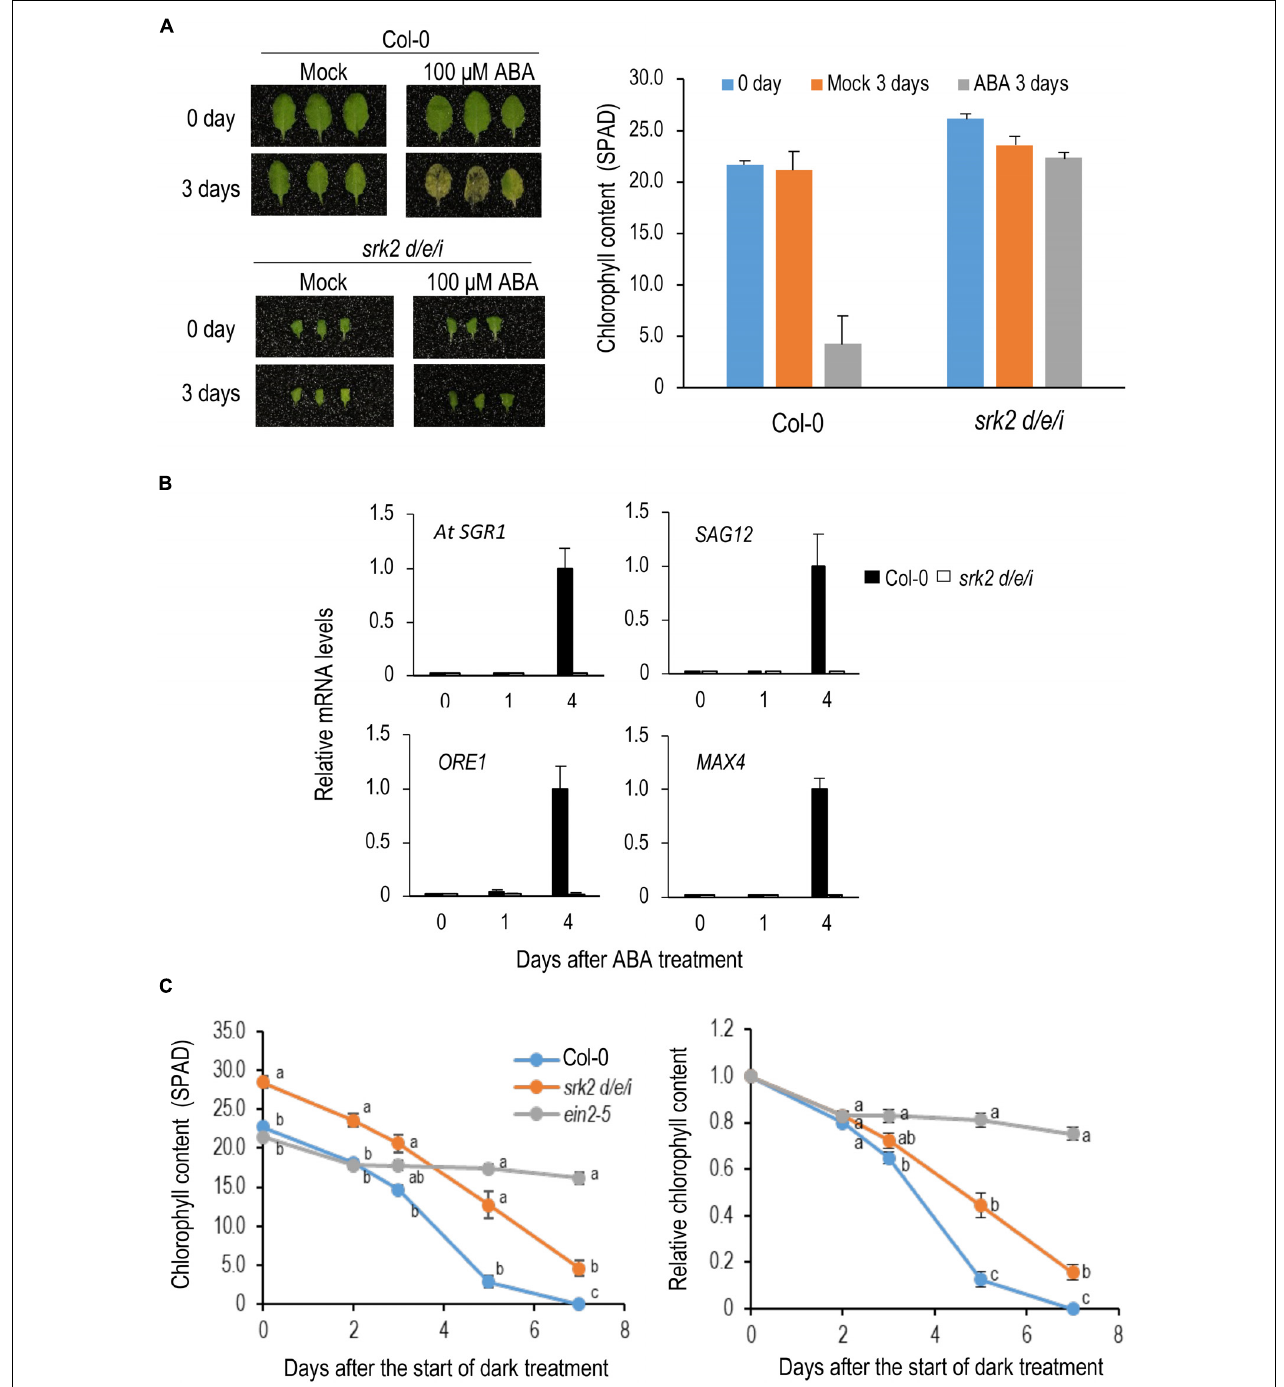
FIGURE 2 | Roles of ABA in dark-induced leaf senescence. (A) Sensitivity of srk2d/e/i to ABA in leaf senescence. Left, leaves in the 8th position from the top of 4-week-old plants were incubated on the medium containing 100 µ M ABA for 3 days under light conditions. Right, Changes in chlorophyll content by ABA treatment. (B) qRT-PCR analysis of changes in transcript levels of senescence-induced genes during ABA treatment. Detached 8th position leaves were used for the analysis. ACT8 was used as a reference. Solid and open bars indicate Col-0 and srk2d/e/i , respectively. Transcript levels were relative to that in Col-0 leaves 4 days after ABA treatment. ACT8 was used as a reference. (C) Changes in chlorophyll content over time in srk2d/e/i during dark incubation. Detached 8th position leaves were used for the analysis. Chlorophyll content is indicated in SPAD value in the left panel and those relative to day 0 are shown in the right panel. Data for the same day after the start of dark incubation were statistically compared using Tukey’s multiple comparison method ( p < 0.05). Bars indicate standard errors ( n = 6, 4, and 8 in A , B , and C , respectively).